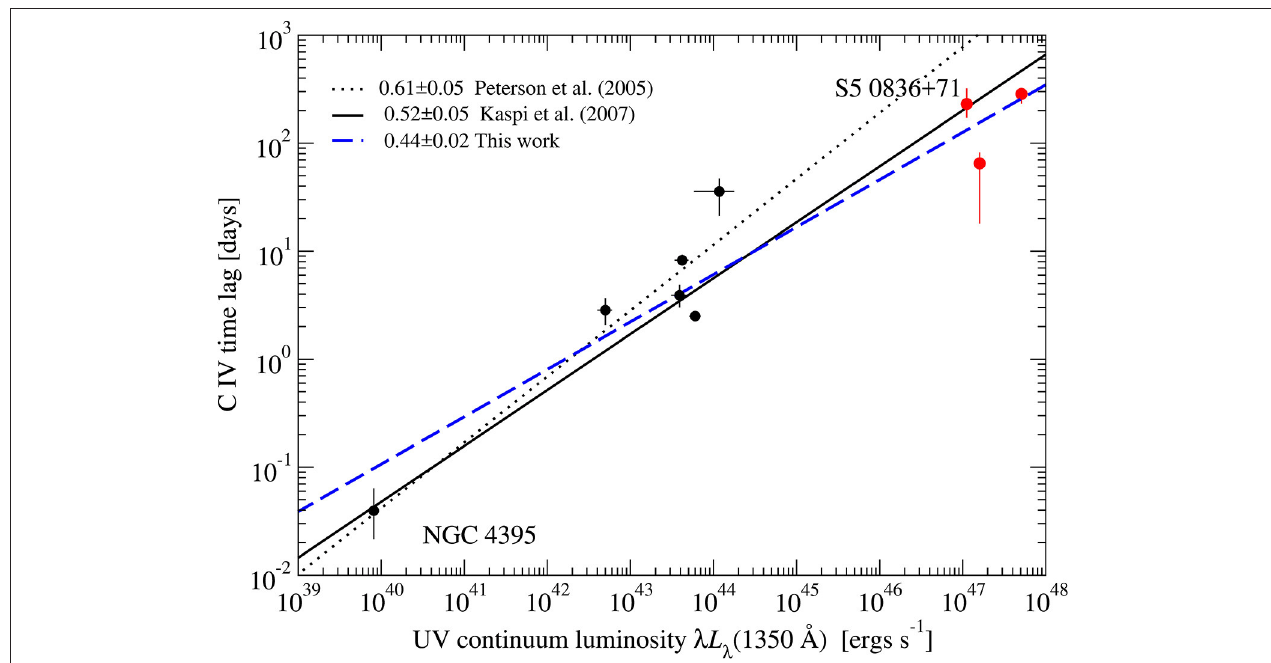
FIGURE 4 | BLR size vs. UV luminosity relation based on the work of Kaspi et al. (2007) together with the three objects reported in this work. See text for